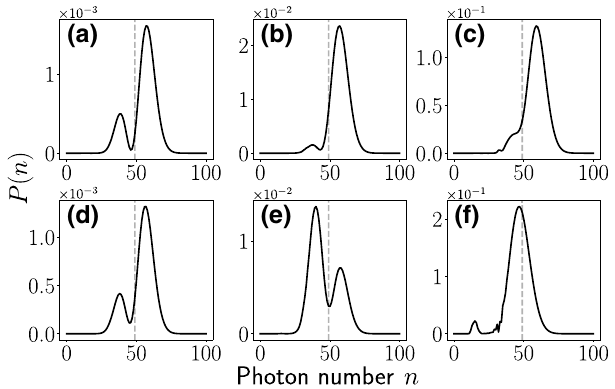
FIG. 8. Photon-number probability distribution (74) for posi- tive (upper row) and negative (lower row) values of the canon- (cid:21) ical momentum. Specifically, we use (a) p = 0.05 U p , (b) (cid:21) (cid:21) (cid:21) p = 0.14 U p , (e) p = U p , (c) p = 0.32 U p , (d) p = − 0.05 (cid:21) (cid:21) − 0.14 U p , and (f) p = − 0.32 U p . We consider a field with a sinusoidal squared envelope with ω = 0.057 a.u., five cycles of duration, and field amplitude E 0 = 0.053 a.u. The vertical gray dashed line shows the location of the maximum photon-number probability for the initial coherent state used in the numerical analysis, i.e., α = 7 i